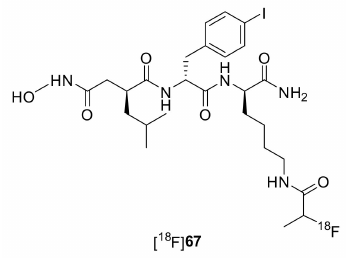
Scheme 16. Chemical structure 67 .